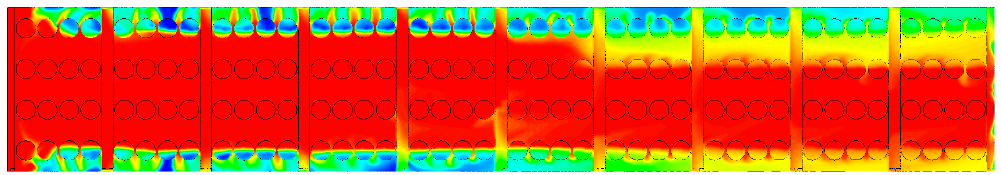
Figure 16. Temperature contour ( a ) at different cross-sections and temperature contour at the top side of the evaporators ( b ), real field and south wind condition.